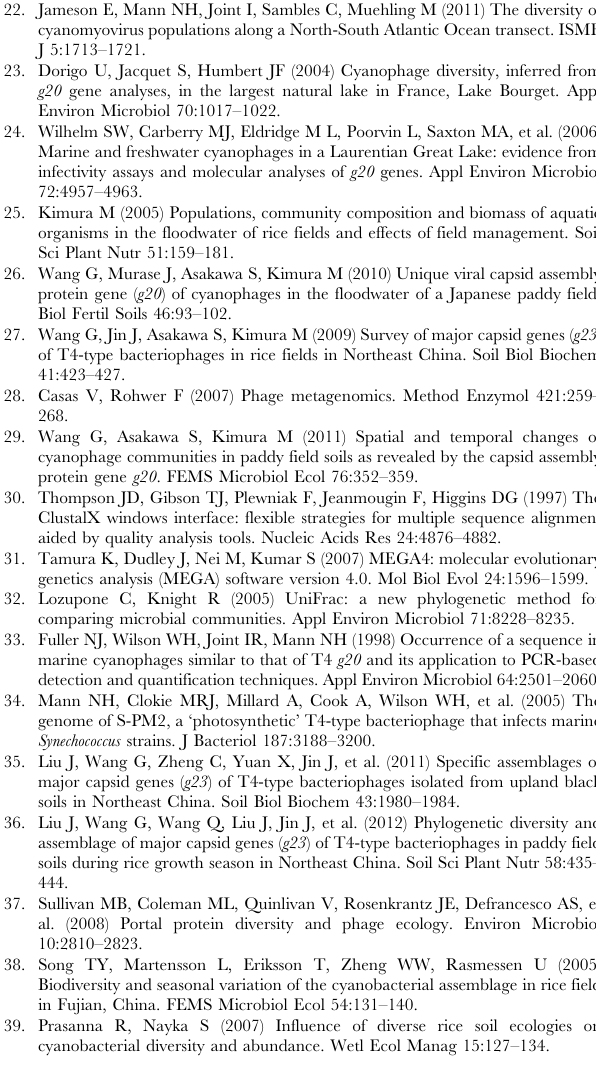
Table S1 Description of samples sites and the number of g20 clones in this study and the corresponding informa- tion from original papers used for UniFrac analysis.